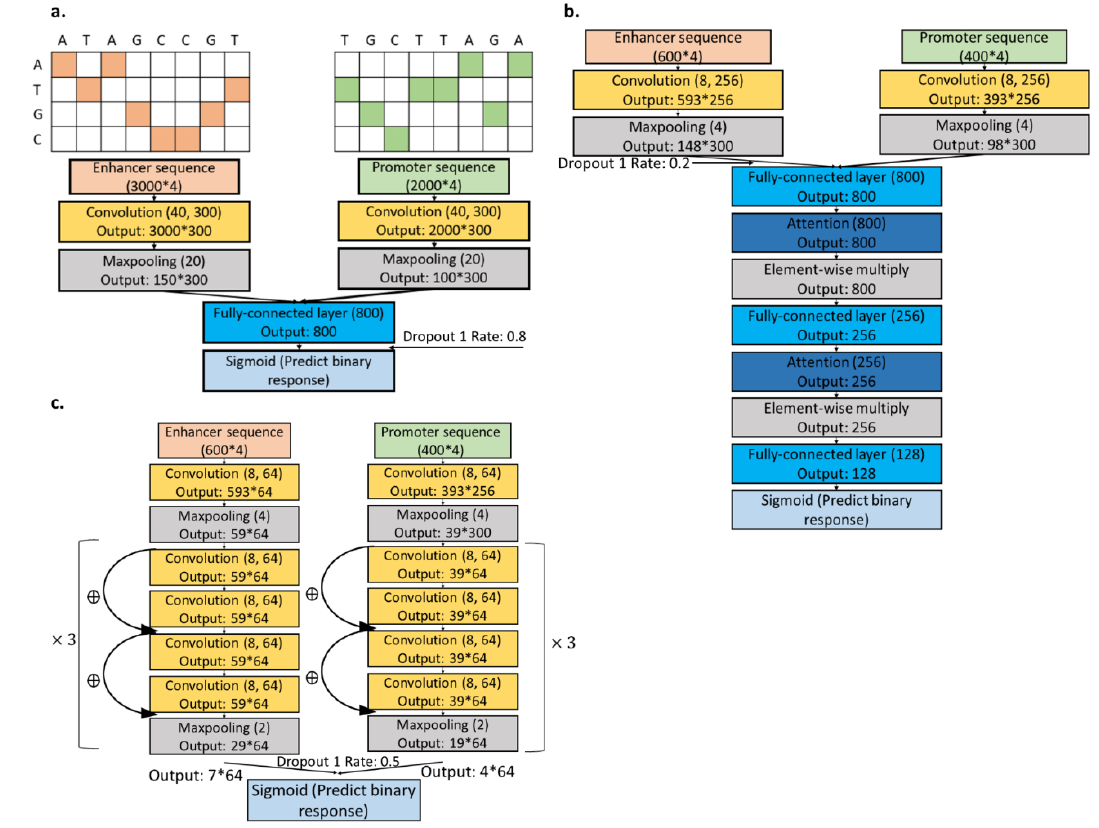
Figure 1. Sequence model structures. ( a ) The structure followes a previously reported simple convolutional model [14]. We used shorter input sequences, each centered as the SPEID data, with attention modules ( b ) or ResNet ( c ).